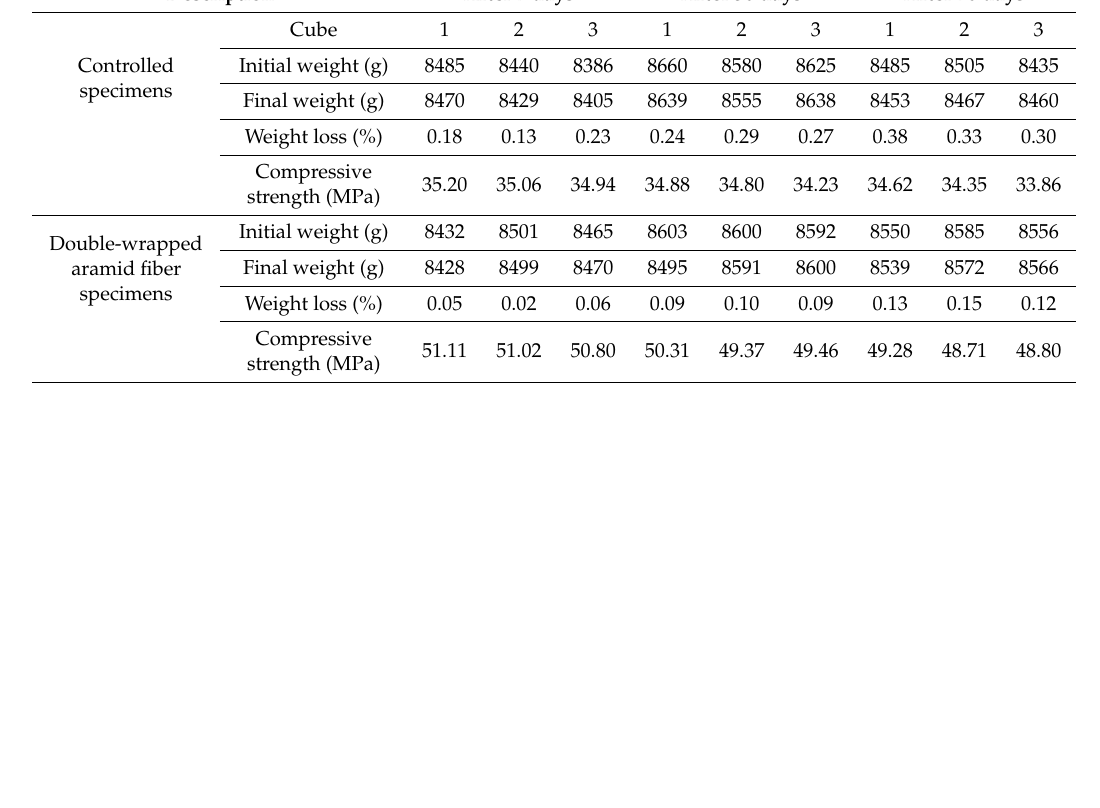
Figure 4. Compressive strength in the acid resistance test.